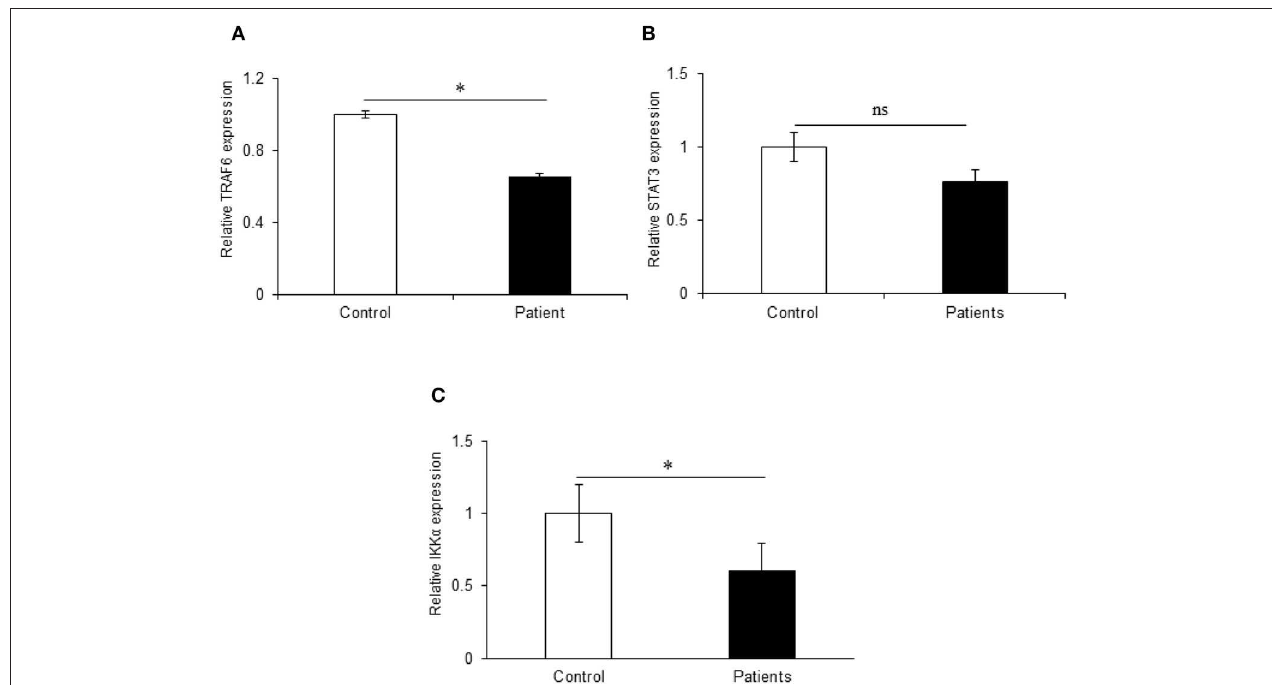
FIGURE 5 | Relative expression of target genes in UC patients. qRT-PCR for target genes was performed in 20 controls and 30 IBD patients. (A) TRAF6 exhibited significant 1.47-fold upregulation in UC patients as compared to non-IBD controls. (B) STAT3 did not show significant changes in expression in UC patients as compared to controls. (C) IKK α showed significant 0.40-fold downregulation in UC patients as compared to controls. GAPDH gene was used as internal reference. * Denotes the level of significance. * p ≤ 0.05. ns, Not significant. Bars represent standard error of the mean